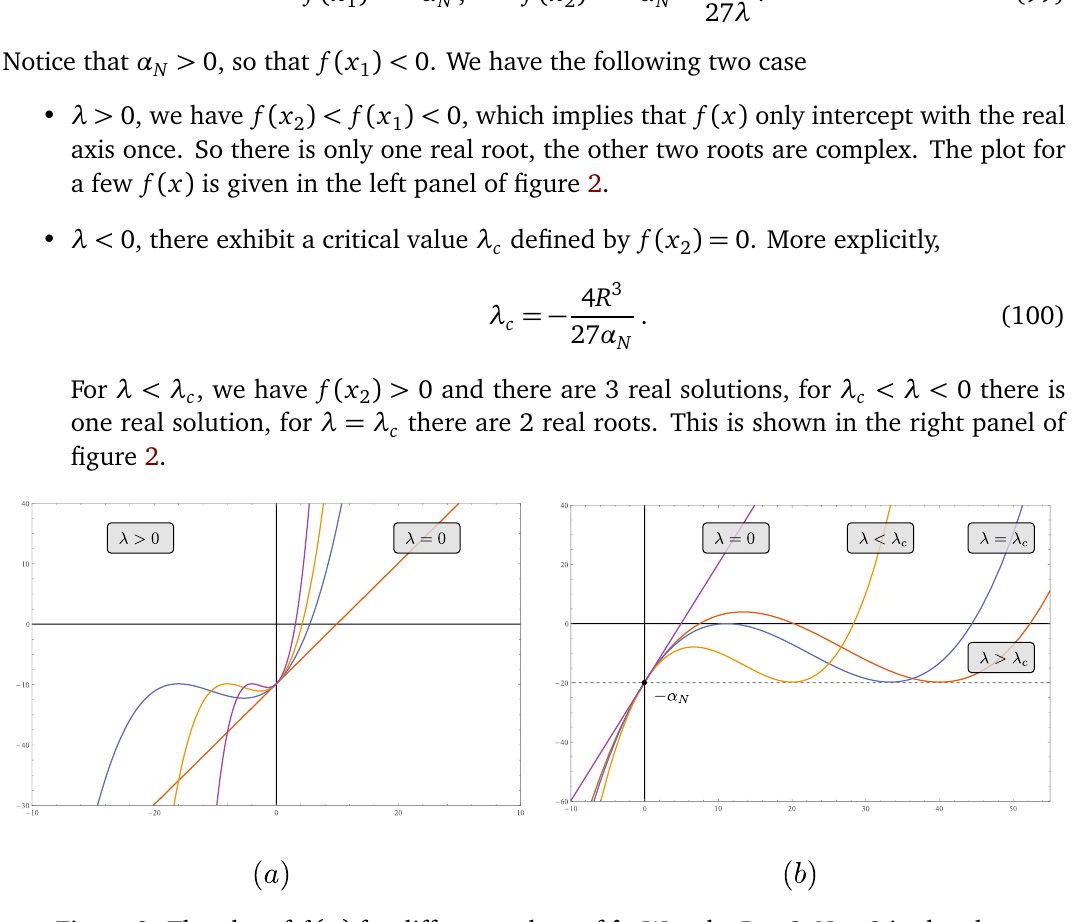
Figure 2: The plot of f ( x ) for different values of λ . We take R = 2, N = 2 in the plot. On the left panel, we plot f ( x ) for different values of λ > 0. There is only one real root for positive λ . On the right panel, we consider different values of λ < 0. There < λ < 0, there 3 real roots, for λ < λ are three cases. For λ c λ = λ there are 2 real c